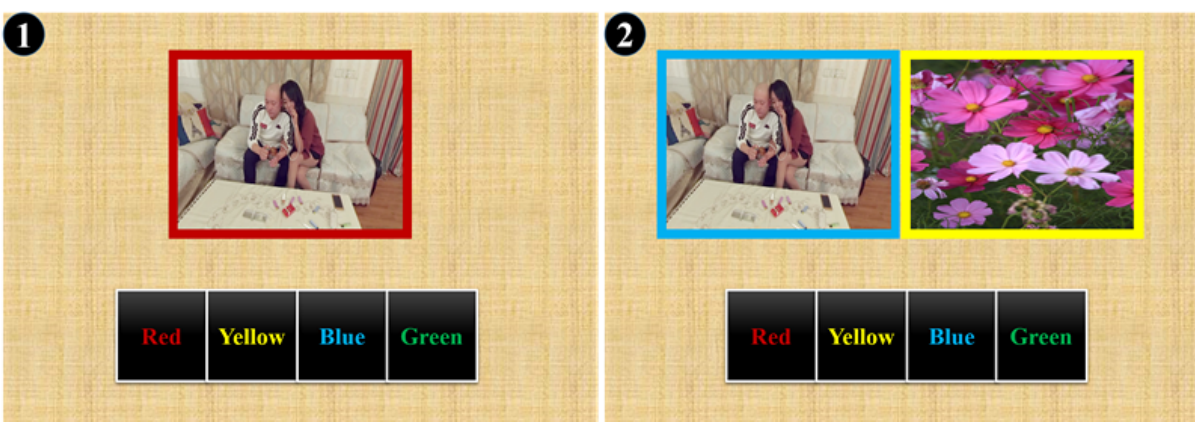
Figure 2. Methamphetamine-related attention control training. In situation 1, the border of the methamphetamine-related image was red, and the patients needed to push the “red” button. In situation 2, the border of the neutral picture was yellow, and the patients needed to push the “yellow” button as quickly as possible.